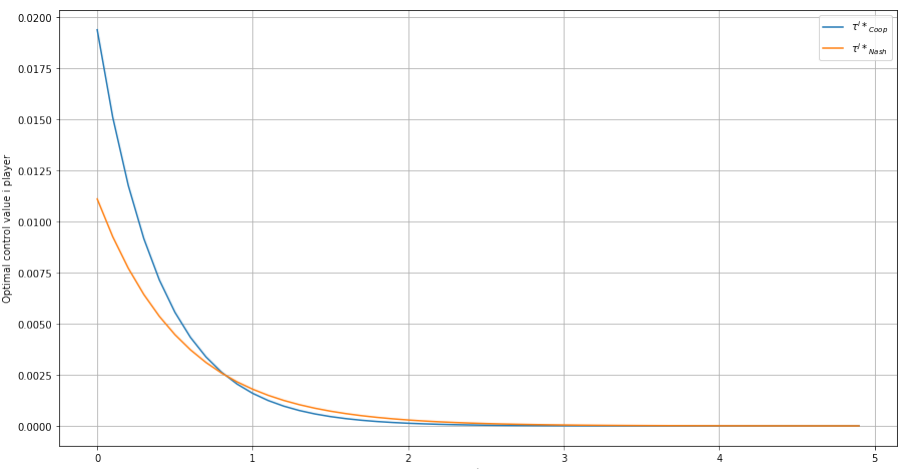
Figure 1. The optimal controls of player i under cooperation VS Nash